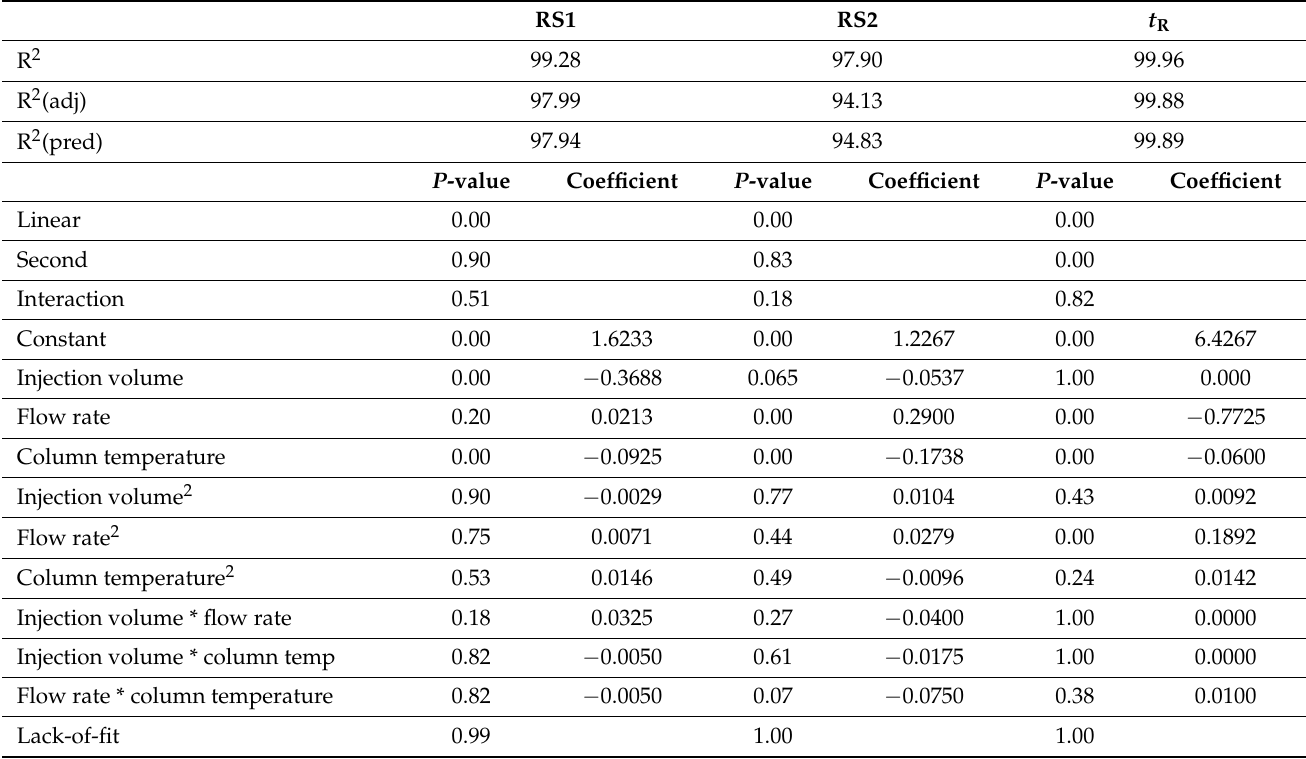
Table 2. ANOVA results for HPLC-DAD method optimisation using Box–Behnken design.